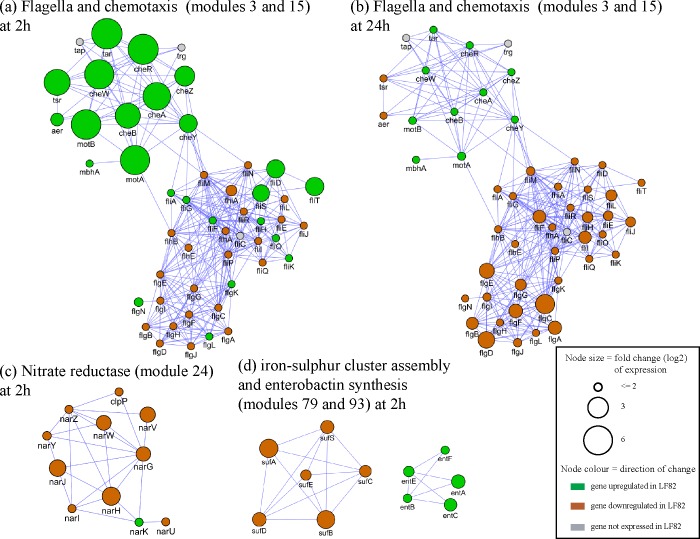
Functional modules differentially expressed in strain LF82 compared to non-invasive strain HS at 2h and 24h time points.As mentioned above, the differences can not be related to the duration of culture vs. the agitation. Functional modules were obtained from a high quality set of protein-protein interaction previously defined for E. coli [36]. Node size indicates fold change (log2) of differential expression (DE) based on the DESeq algorithm [33]. Node color indicates direction of regulation. Flagella and chemotaxis module: (a) most chemotaxis genes are up-regulated in LF82 relative to HS at 2h (DE > 3), while at 24h (b), half of the flagella genes are down-regulated in LF82 (DE > 2). (c) Most nitrate reductase genes are down-regulated in LF82 at 2h (DE > 2). (d) At 2 hours, iron-sulphur cluster assembly genes in LF82 are down-regulated (DE > = 2.7), and enterobactin synthesis genes (involved in iron transport) are up-regulated (DE > = 2.3).